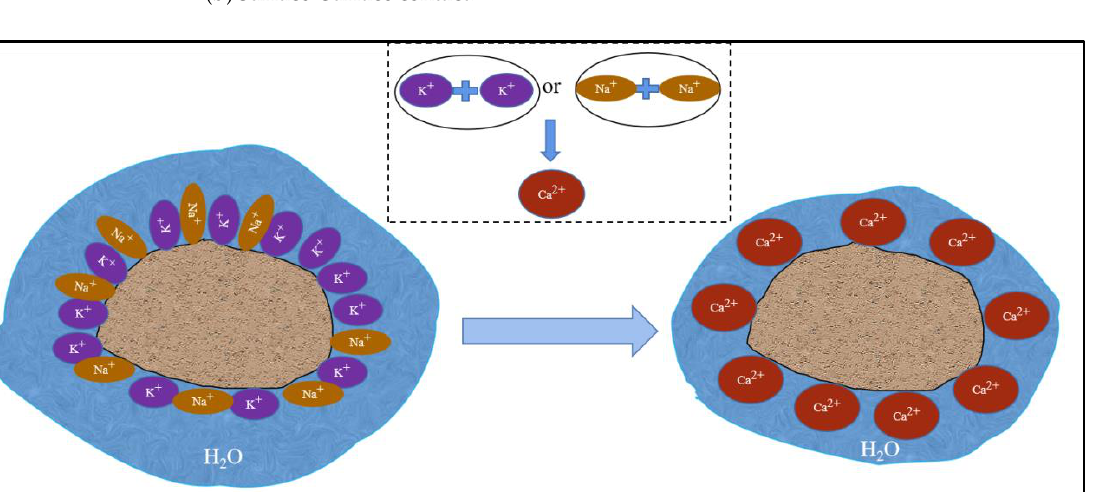
Figure 16. Ion exchange reaction.